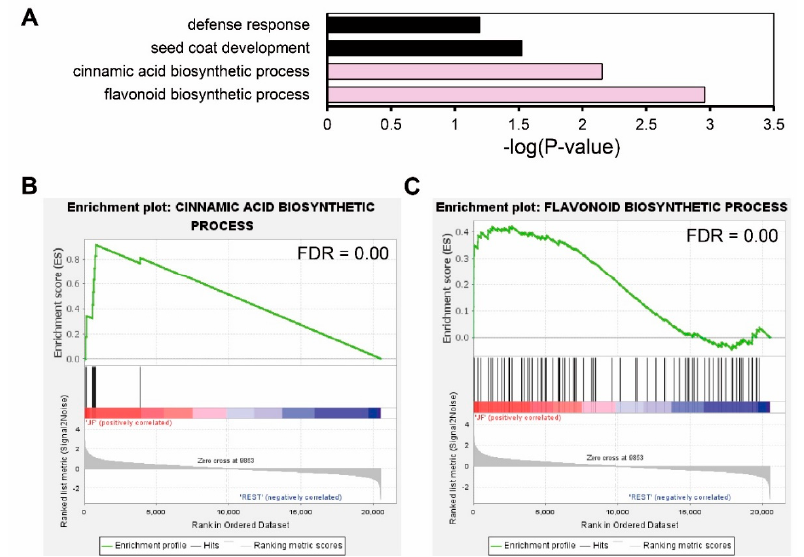
Figure 4. Gene Ontology analysis of common DEGs regulated in same direction indicates flavonoid biosynthesis was up-regulated in JF. ( A ) GO analysis of common DEGs. Significance of enrichment is depicted by -log( P -value) in the x axis. Pink filled bars indicate anthocyanin precursor biosyn- thetic process terms. ( B, C ) GSEA (gene set enrichment analysis) of flavonoid biosynthetic process genes. GSEA rank was calculated by JF vs. REST (DF and cJF). Common DEGs that were regulated in same direction both in JF vs. DF and JF vs. cJF were used as a query.